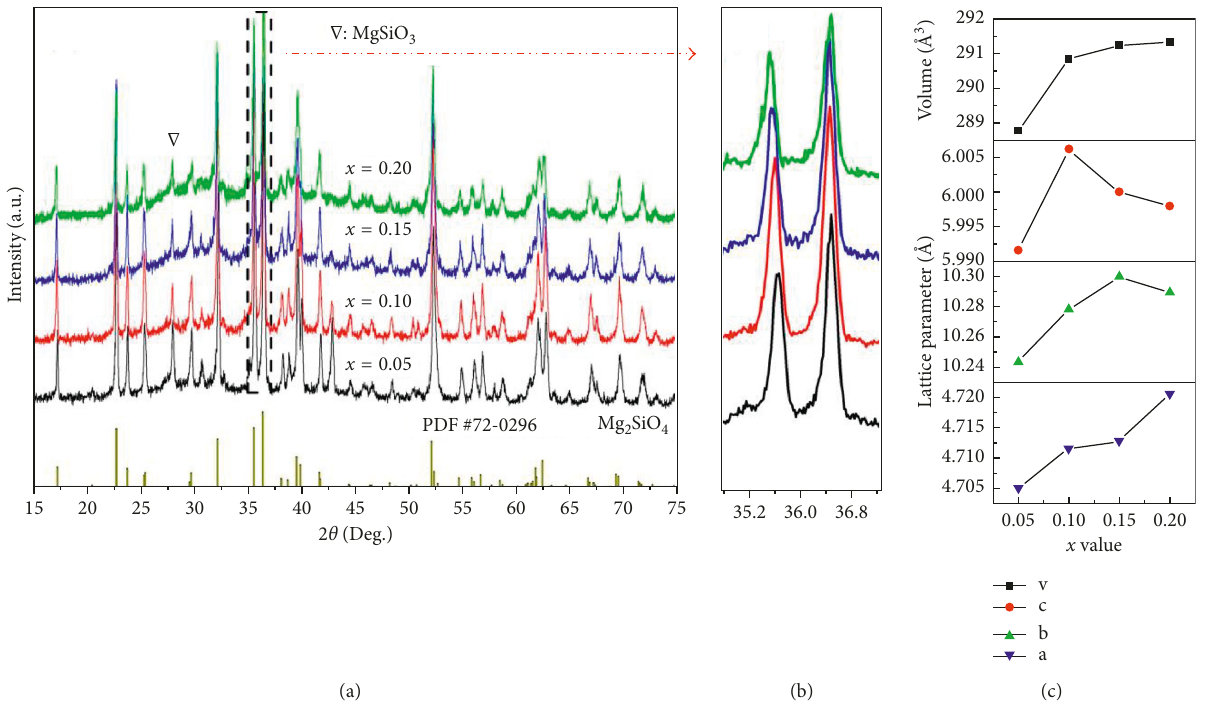
Figure 1: (a) XRD patterns of (Mg 1 x Cu x ) 2 SiO 4 ( x (cid:31) 0.05–0.20) ceramics sintered at 1300 ° C for 4h; (b) locally magnified peak profiles indicated in (a); (c) the lattice parameters as a function of the x value. −